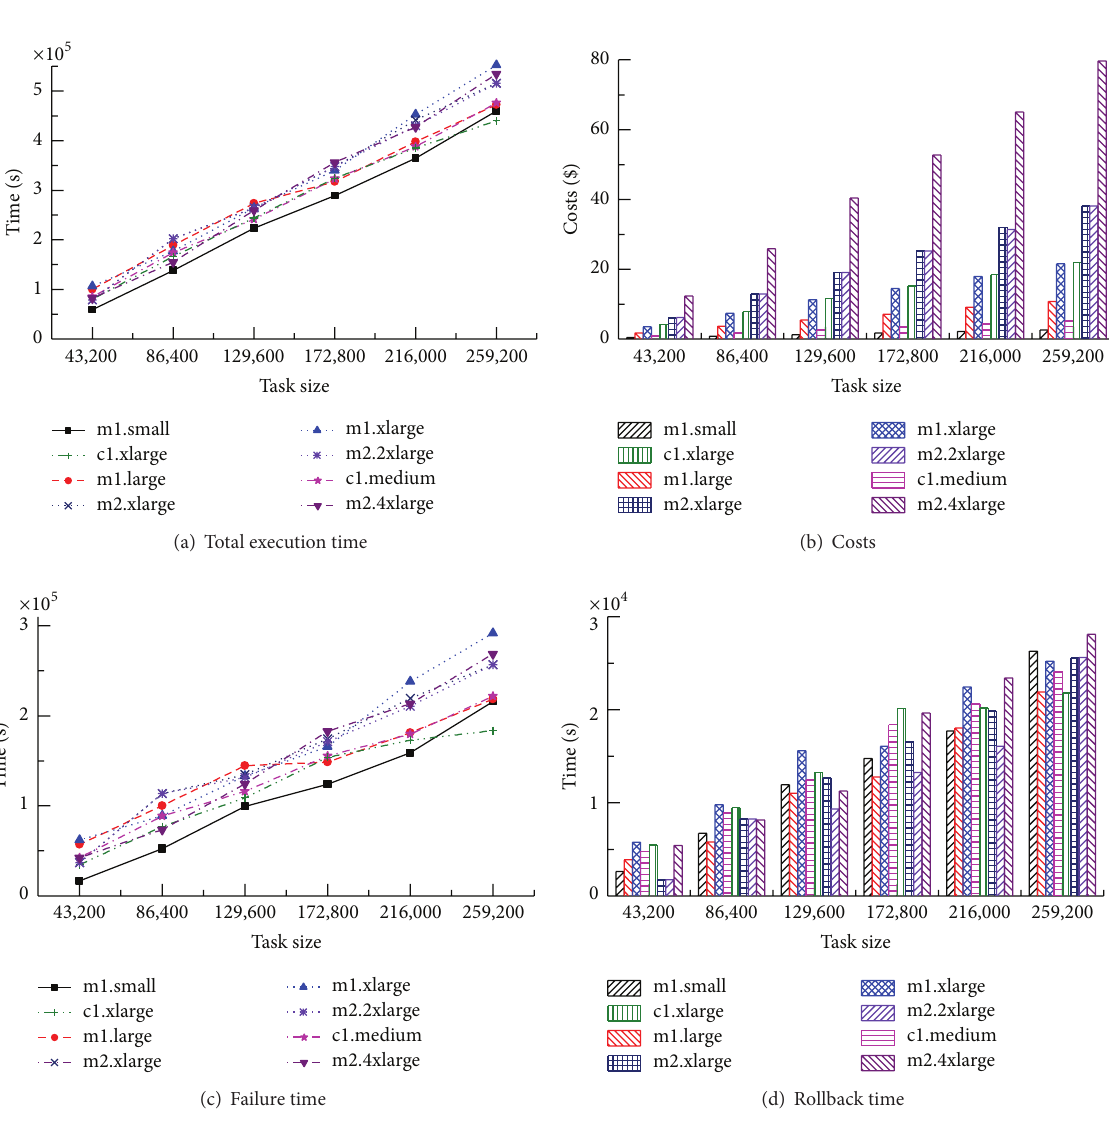
Figure 5: Simulation result in each